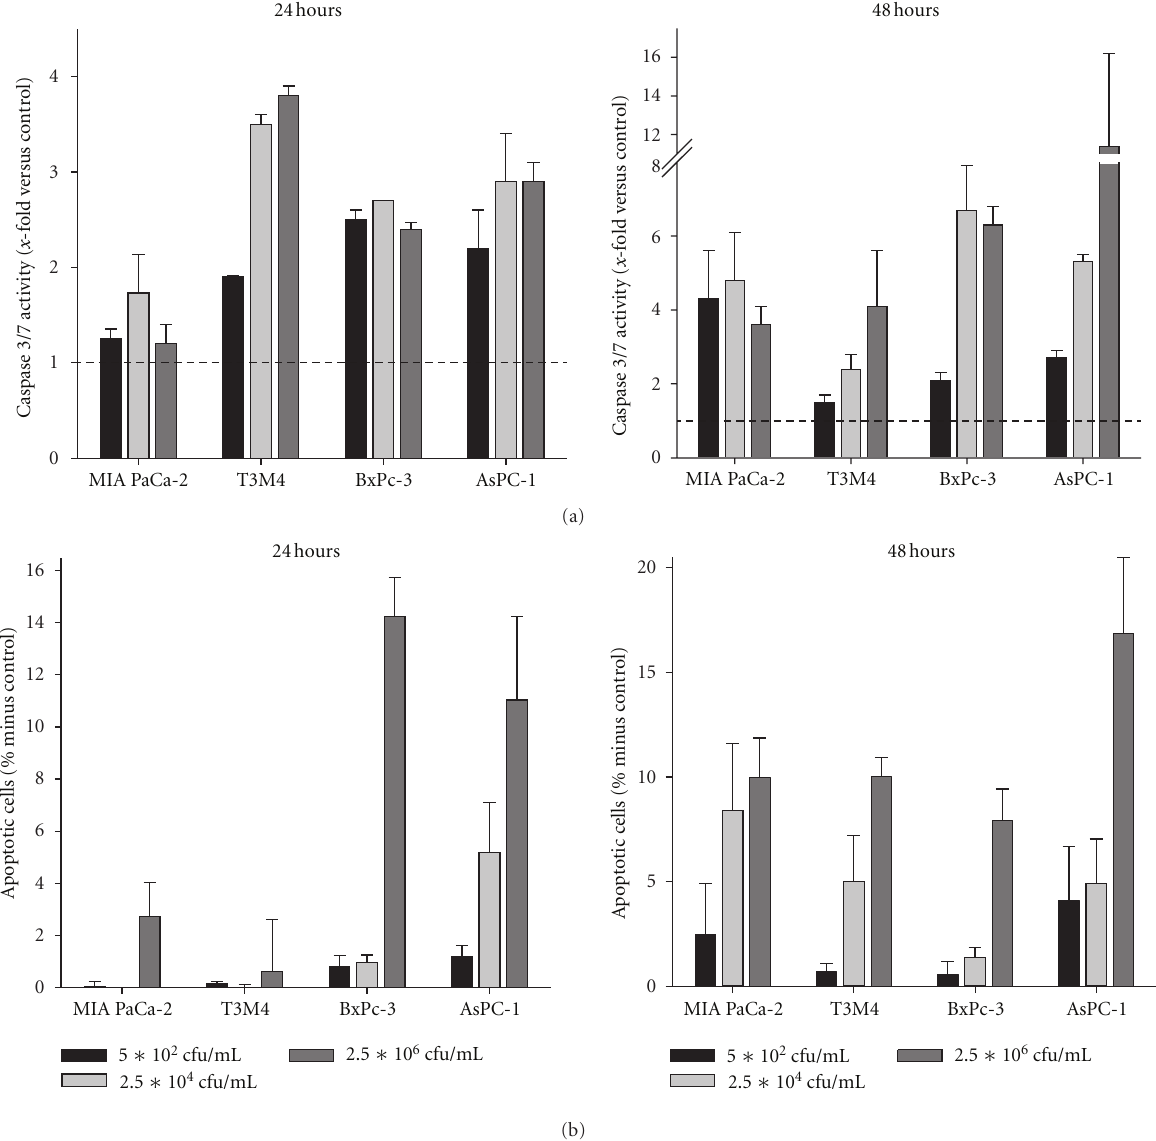
Figure 3: Apoptosis assay. (a) Increased Caspase 3/7 activity in tumor cells after CT treatment, as quantified using the Promega Caspase-Glo 3/7 Assay according to the manufacturer’s instructions and measurement on a luminometer. (b) Flow cytometric sub-G1 Peak analysis following 24 and 48hours of incubation with CT. Cells with DNA content lower than the G1 peak were considered to be apoptotic. Results show data of three separate experiments each performed in duplicates. Values are given as the mean ± SEM. (c) AsPC-1 cells show characteristic sub-G1 peaks at 24 hours after treatment (representative results out of three independent